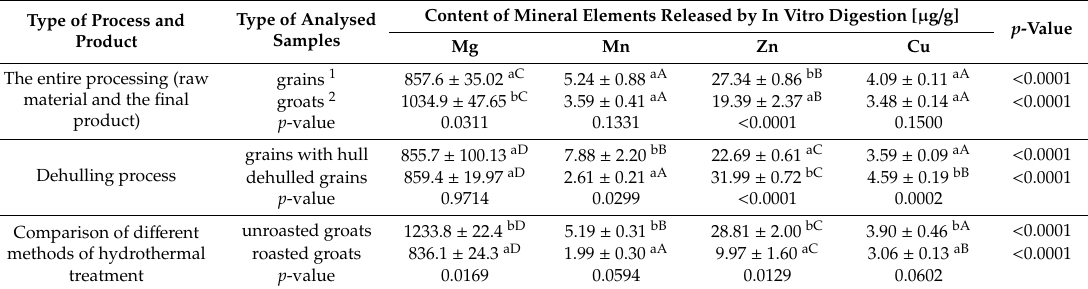
Figure 3. The bioaccessibility [%] of analysed minerals from different types of buckwheat products. Table 2. The content of selected minerals released by enzymatic digestion from analysed samples depending on the technological process (mean ± SD; values in µ g /